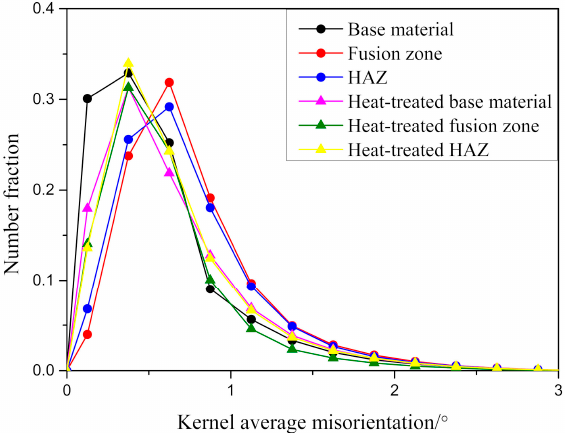
Figure 10. Distribution of kernel average misorientation (KAM) of different regions in the as- joined and heat-treated